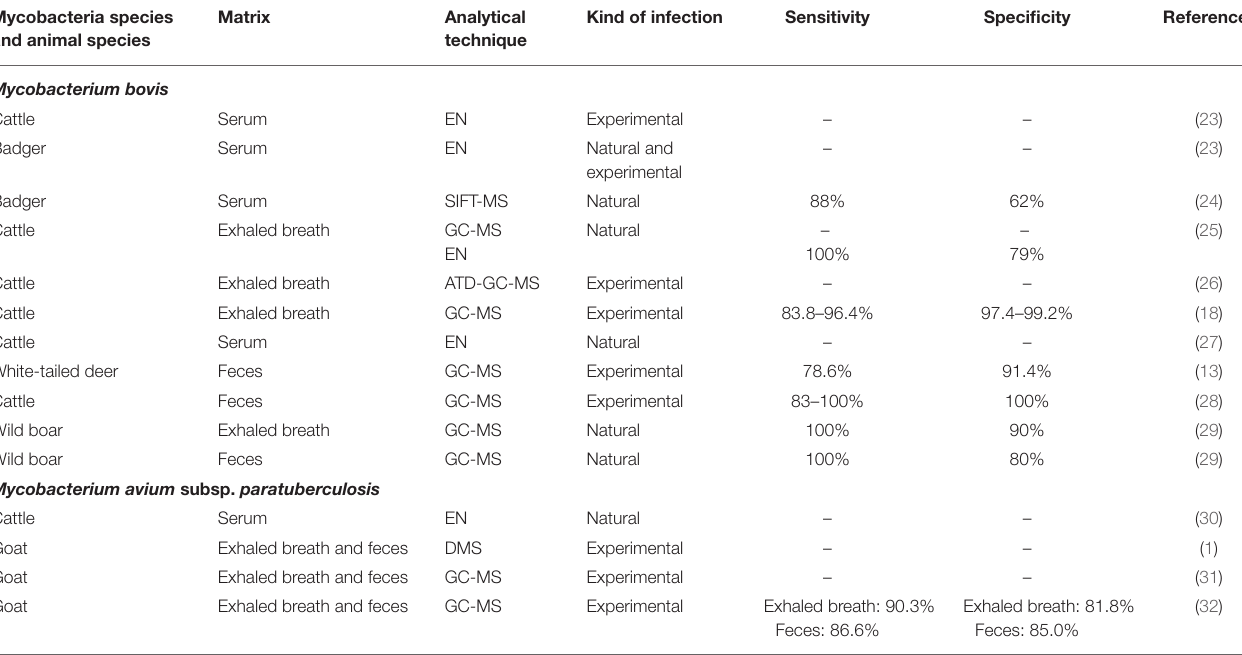
TABLE 1 | In vivo studies evaluating VOC analysis as a diagnostic tool for mycobacterial infection in animals. Mycobacteria species and animal